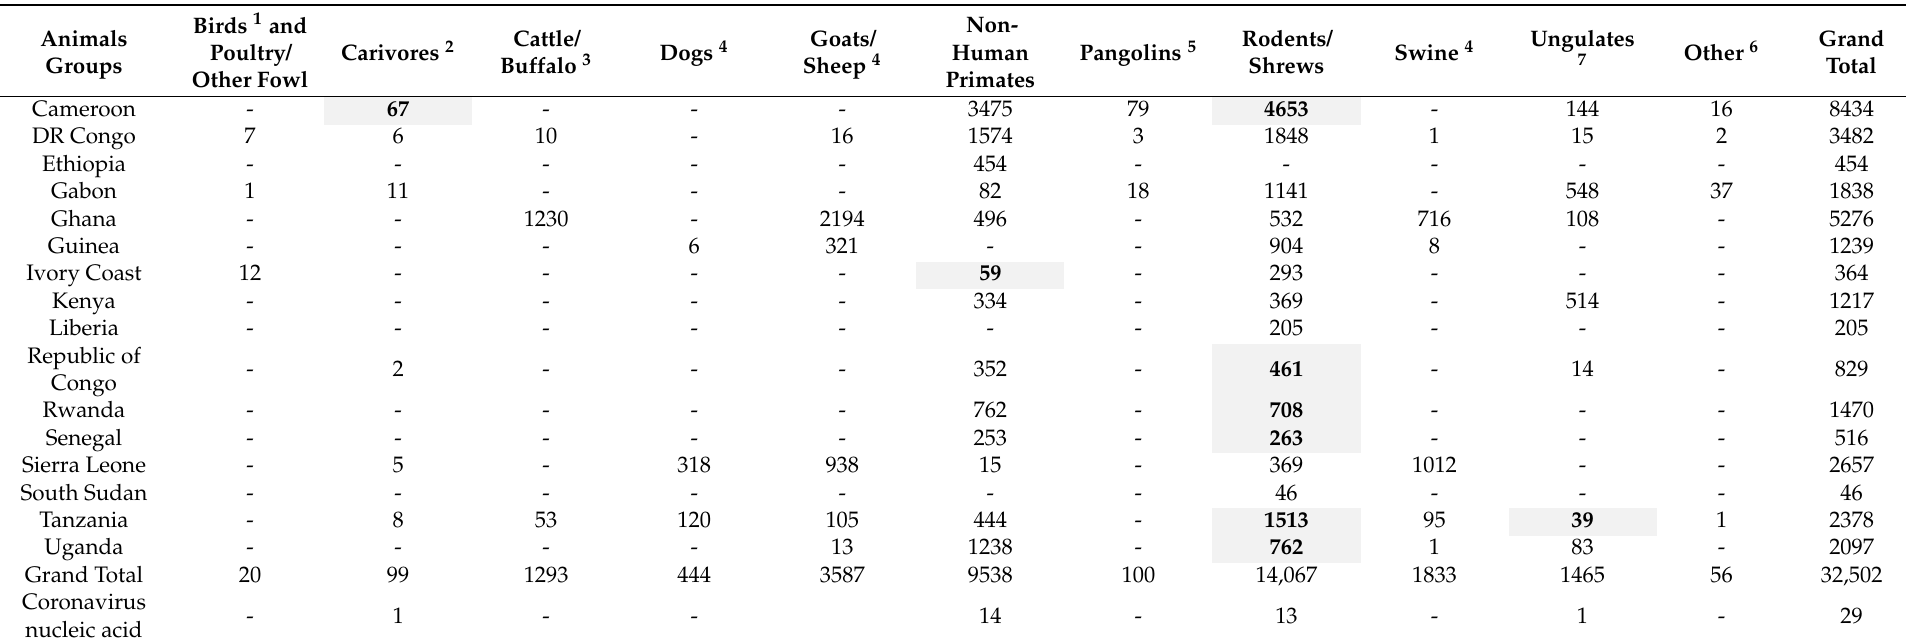
Table 4. Summary of animals (non-bat) tested for coronavirus nucleic